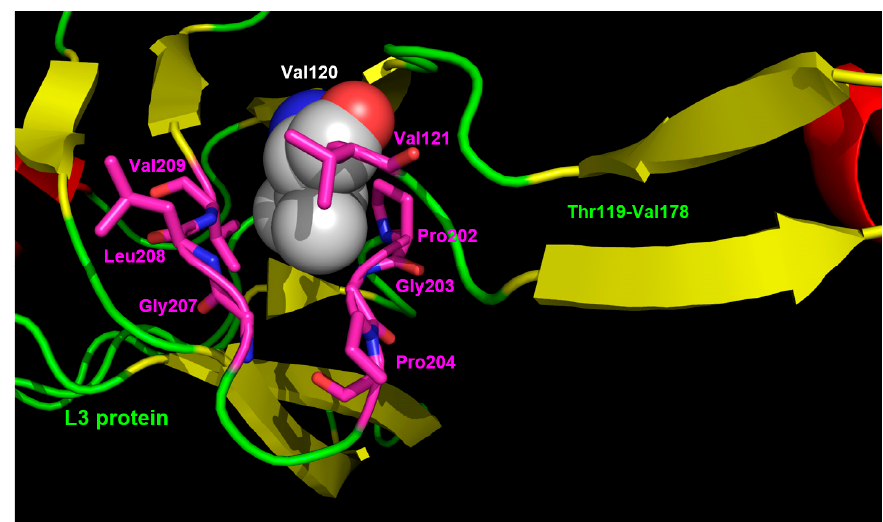
Figure 5. Close-up of the L3 region surrounding position 120. A valine residue is shown at position 120 to highlight the close contacts with residues 202–204 and 207–209. Residues are colored by atom type: nitrogen atoms are shown in blue, oxygen in red, carbon atoms of Val120 are in light gray, and carbon atoms of residue at close contact with Val120 side chain are in magenta.